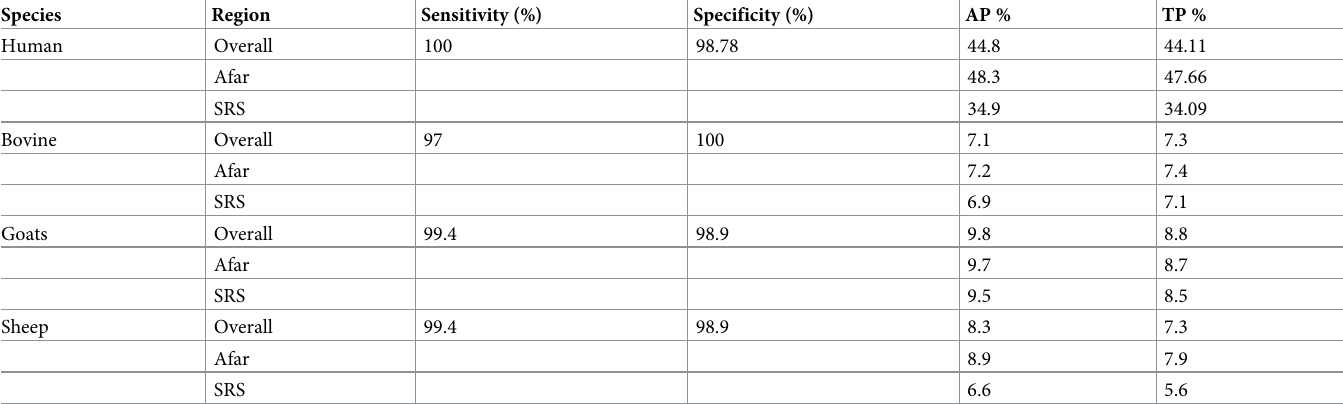
Table 4. Comparing apparent prevalence (AP) and true prevalence (TP) by species and region.